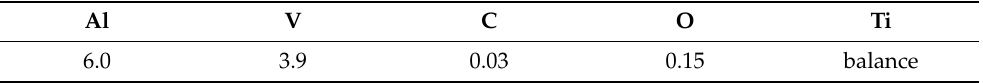
Table 2. Chemical composition of Ti6Al4V two-phase titanium alloy (wt.%), adapted from ref. [34].